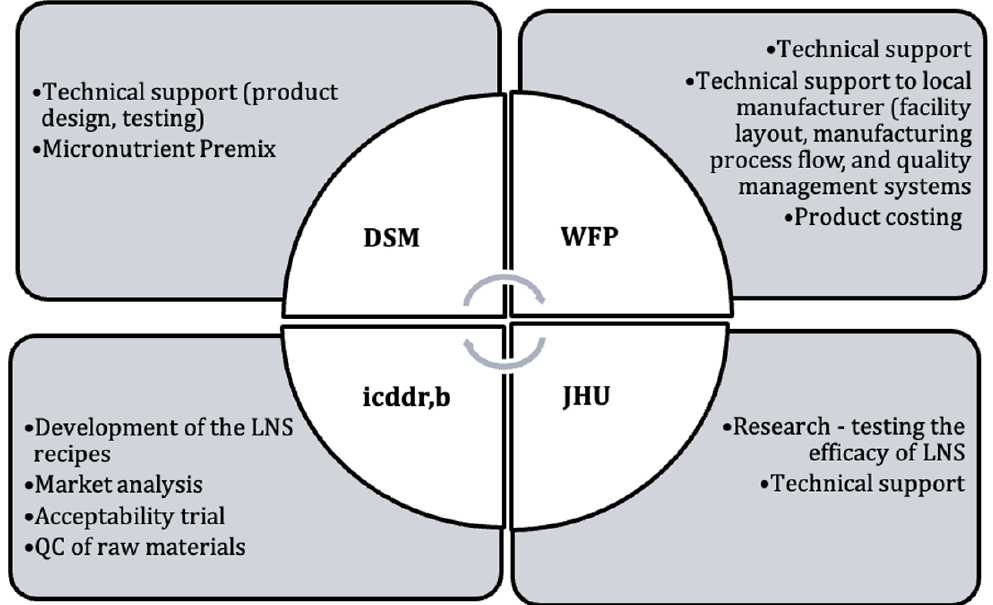
Figure 1. Participating organizations and general